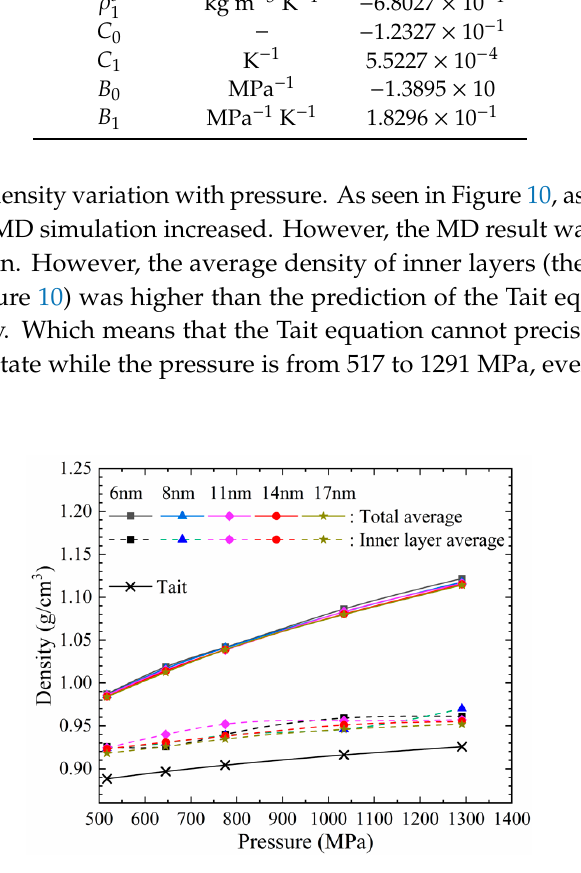
Figure 10. Density predictions of MD simulation and the Tait equation .